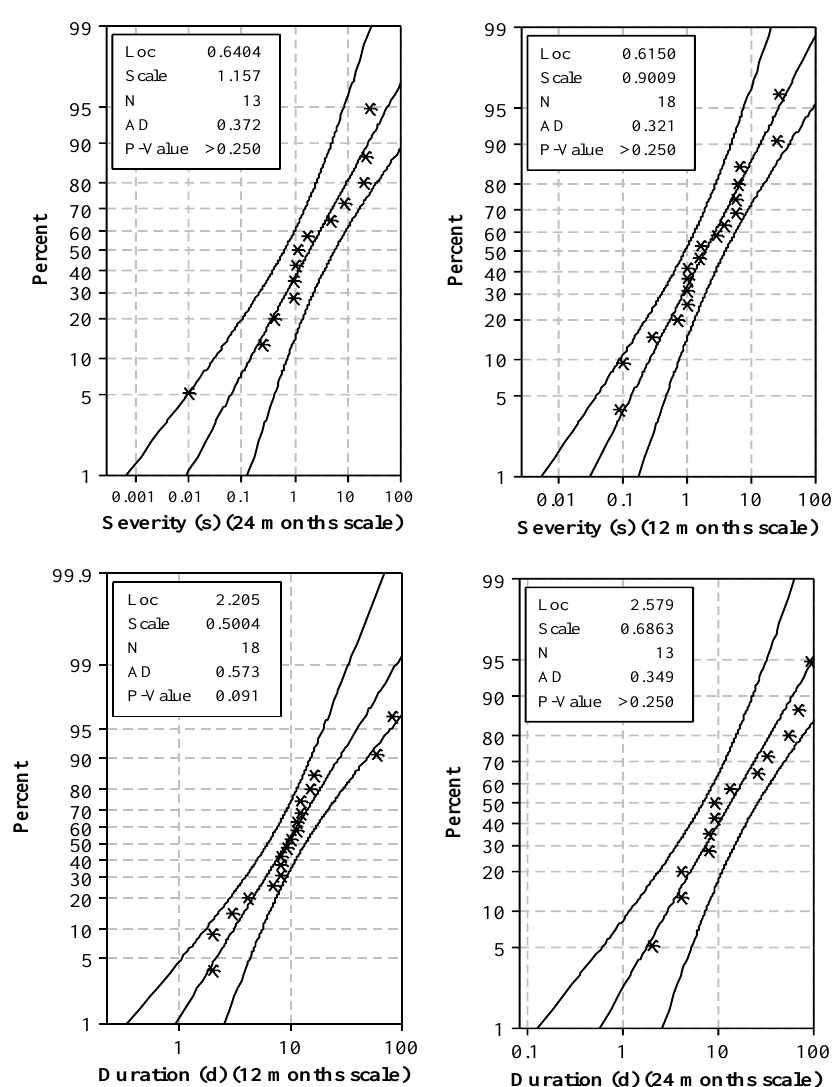
Figure 8. Log-logistic probability fit for drought severity and duration based on 12-month and 24-month timescales. AD stands for Anderson darling test score.